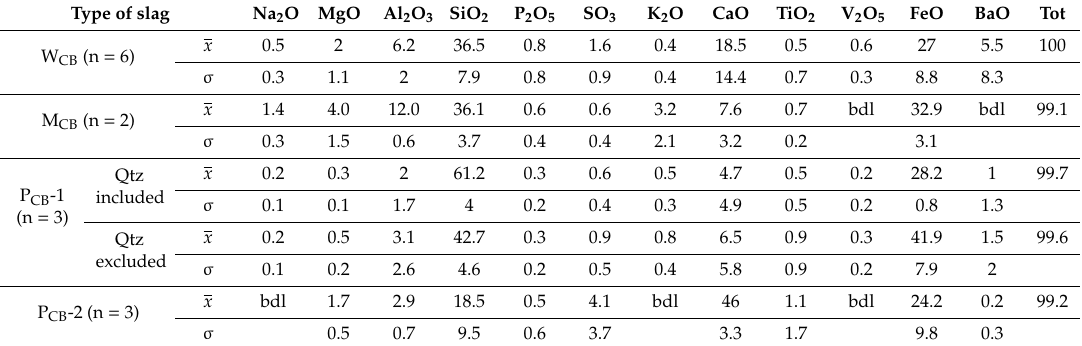
Table 6. Averaged bulk-area chemical analyses by SEM-EDS of slag according to bloom-consolidation